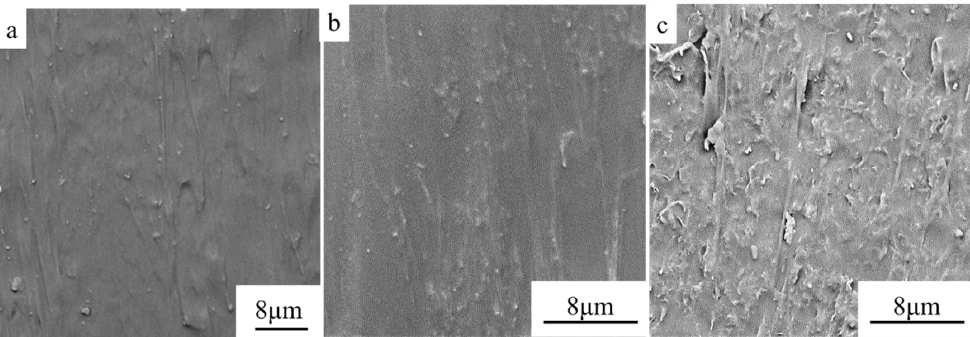
Figure 4. Scanning electron microscope (SEM) images of surface morphology of the composite films